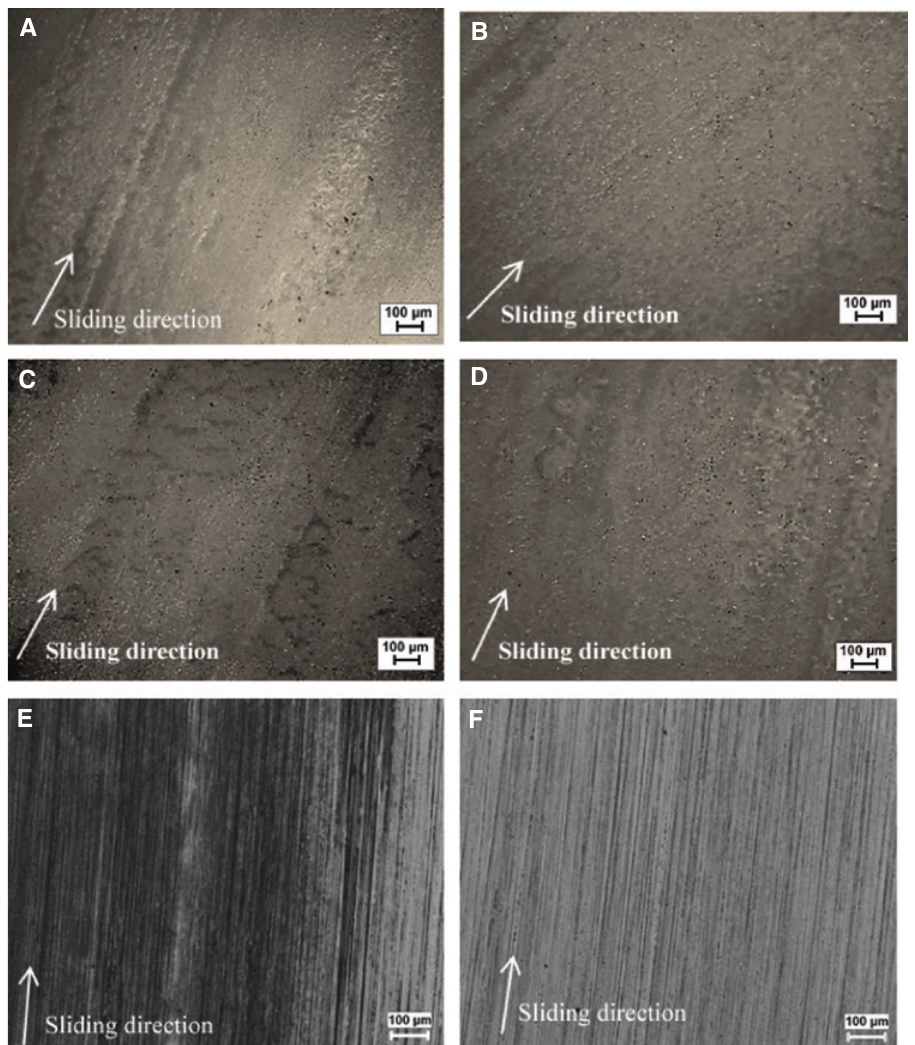
epoxy composites at 0.4 m/s sliding speed and 15 N load condi- Figure 10: Optical micrographs of worn pin and disc surfaces of nano-TiO 2 tions. (A) Worn pin surface of pure epoxy, (B) worn pin surface of 2.5 wt% nano-TiO -filled epoxy composite, (C) worn pin surface of 5 wt% 2 nano-TiO -filled epoxy composite, (D) worn pin surface of 10 wt% nano-TiO -filled epoxy composite, (E) worn disc surface of pure epoxy, 2 2 (F) worn disc surface of 10 wt% nano-TiO -filled epoxy 2